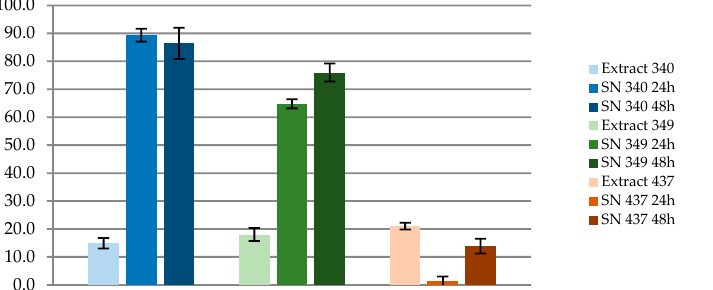
Figure 2. BPA relative percentage of degradation by human fecal specimens. (LC-MS/MS) system was used for BPA quantification; SN: Supernatant.